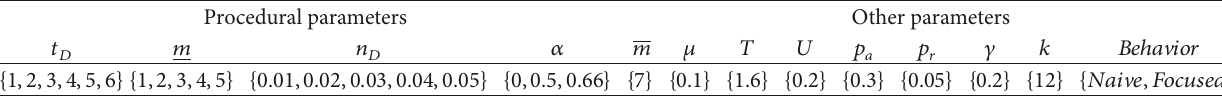
Table 2: Parameters and their domains used to study the effect of the procedural parameters on the